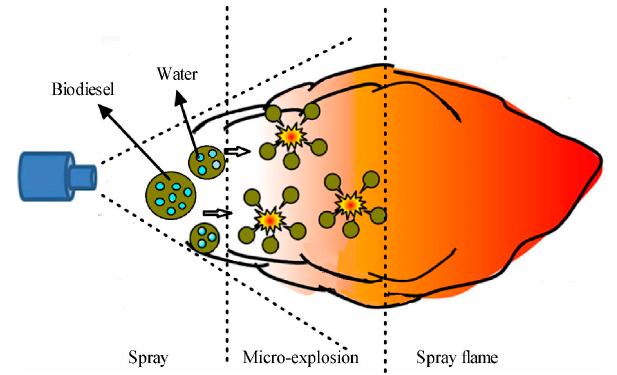
Figure 6. Micro ‐ explosions in emulsion fuels [70]. Figure 6. Micro-explosions in emulsion fuels